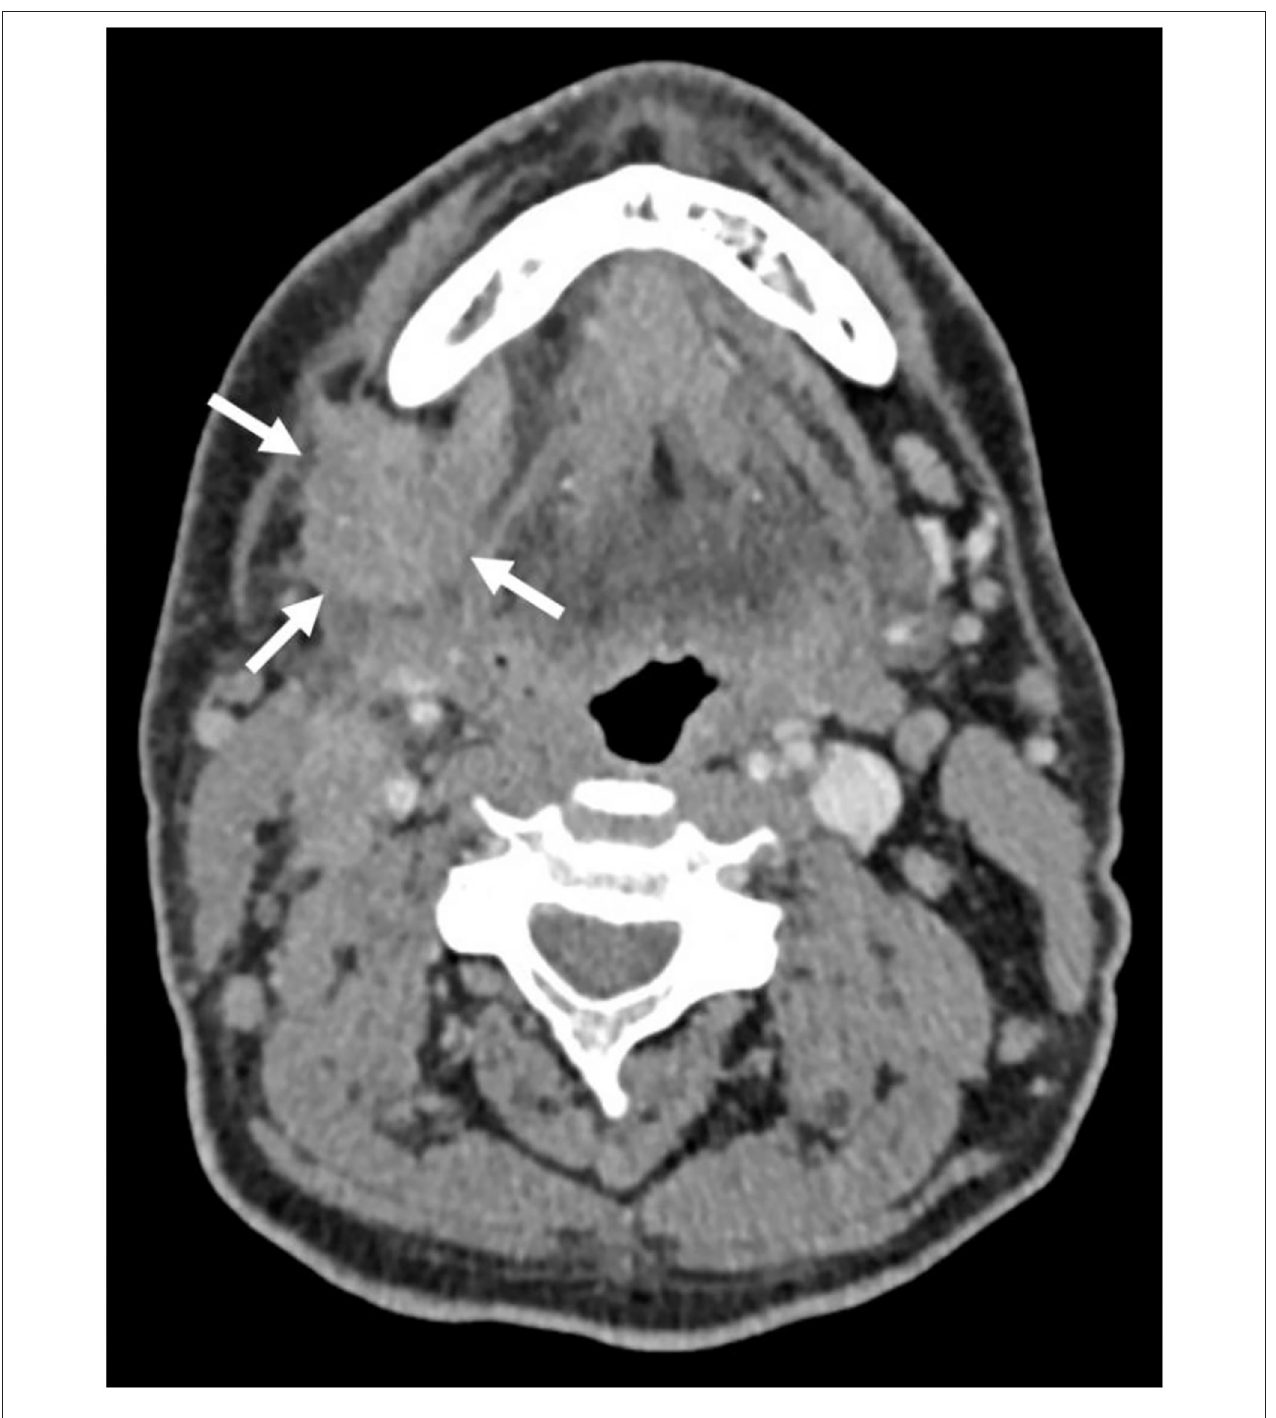
FIGURE 4 | CT image of primary submandibular SDC tumor (indicated by white arrows).